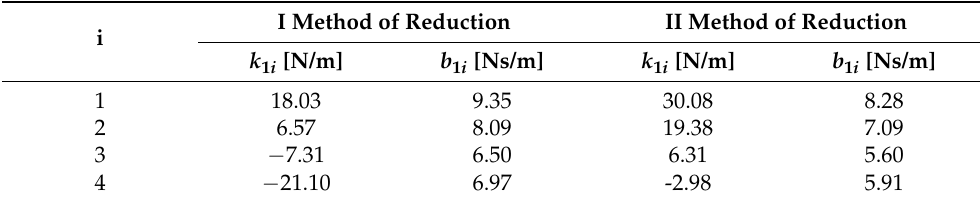
Table 1. Determined dynamic parameters of active